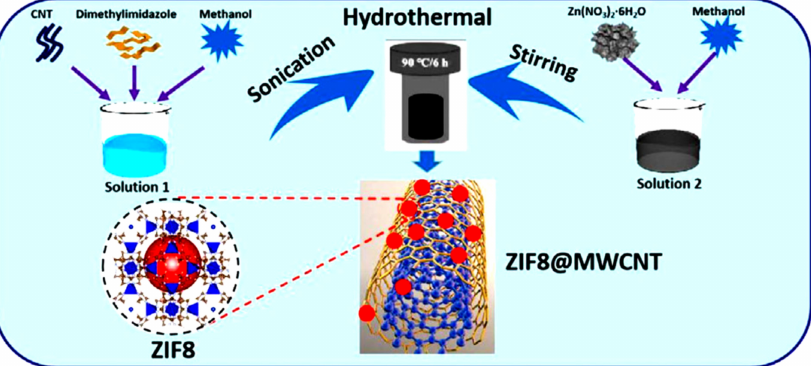
Figure 22. Preparation of the ZIF8@MWCNT nanocomposite. Reprinted with permission from